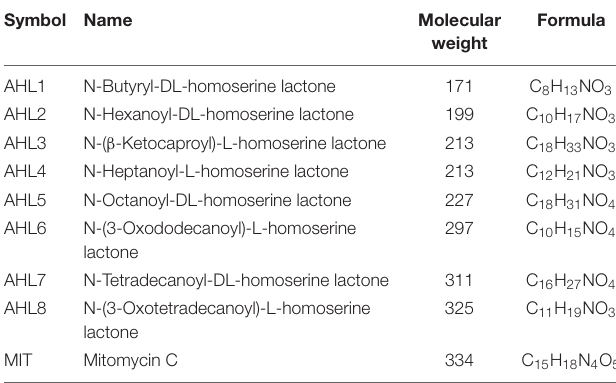
TABLE 1 | homoserine lactones (AHL1–8) and mitomycin C (MIT), used as prophage-inducing agents in this